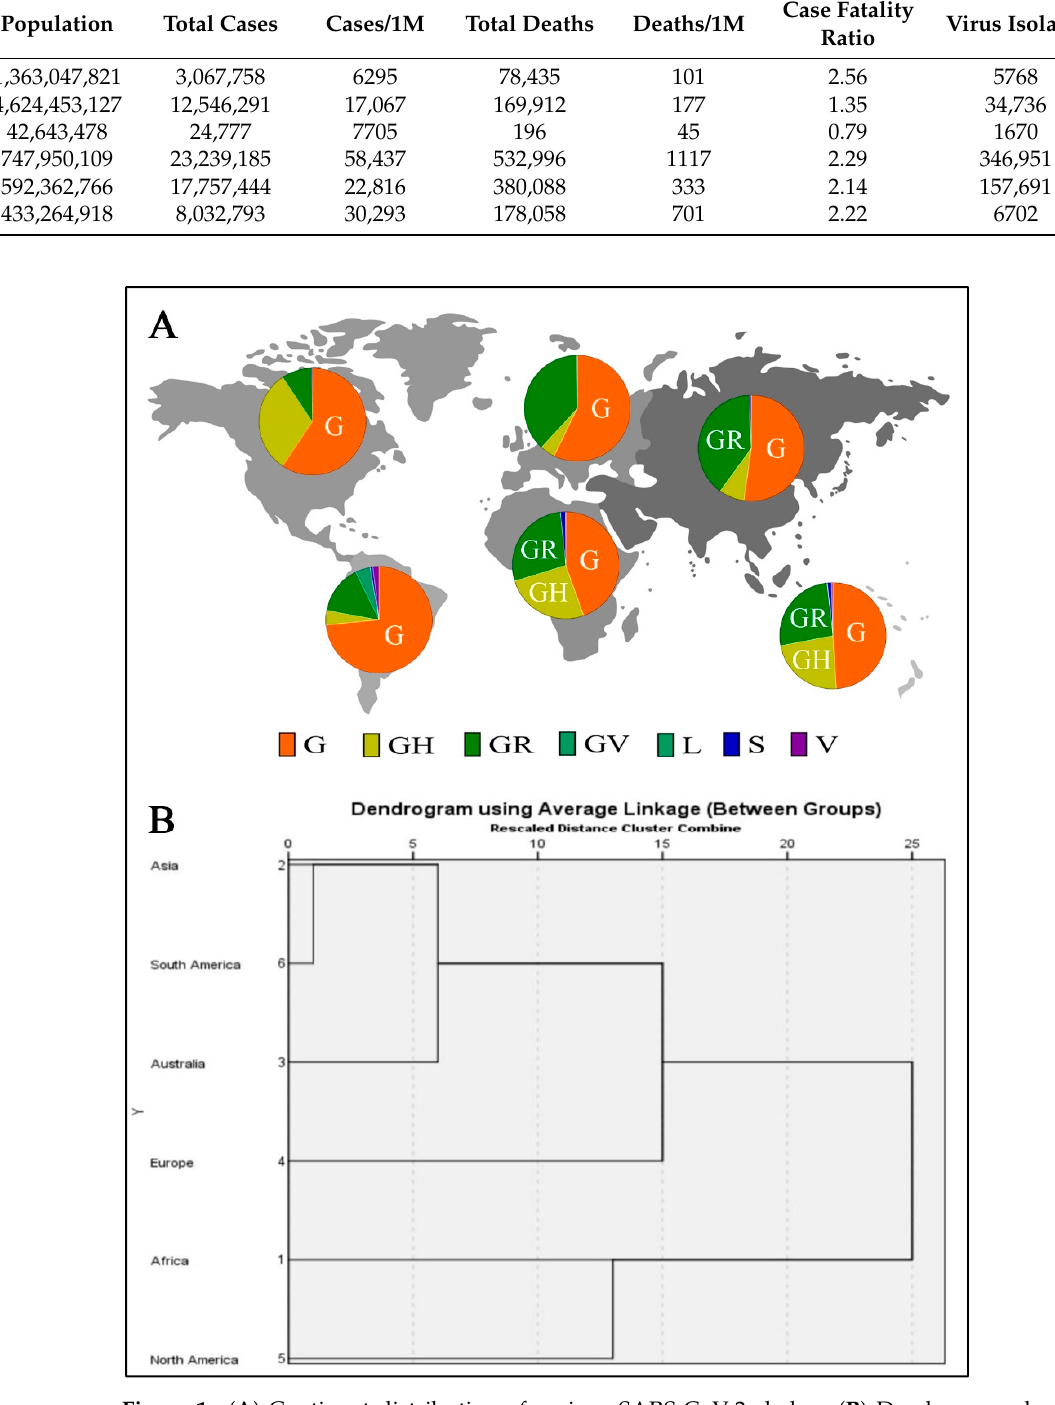
Figure 1. ( A ) Continent distribution of various SARS-CoV-2 clades. ( B ) Dendrogram showing clustering of SARS-CoV-2 isolates from different continents. The cluster analysis of the mutations indicates similarity among SARS-CoV-2 isolates from South America and Asia; isolates from Australia have a similarity to those in America and Asia and a lesser degree similarity among SARS-CoV-2 isolates from Europe and Africa. On the other hand, isolates from North America were least similar to those from other regions (Figure